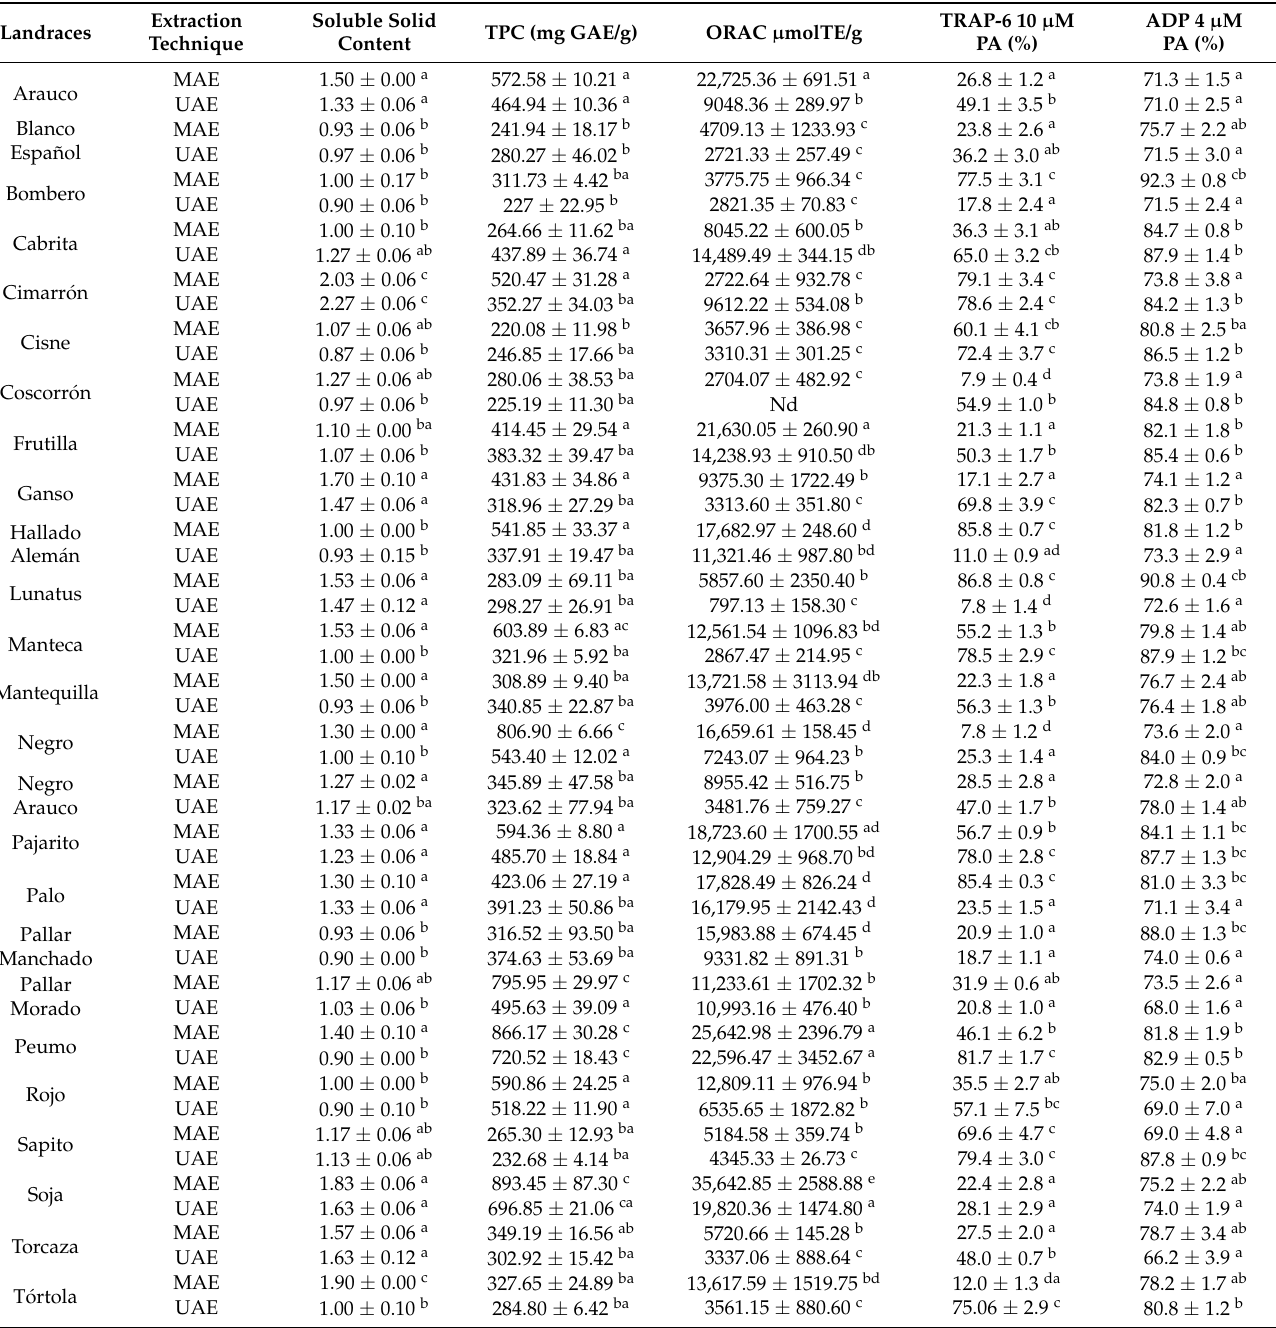
Table 1. Results of the content of soluble solids, total phenols and antioxidant activity of 25 landraces of P. vulgaris